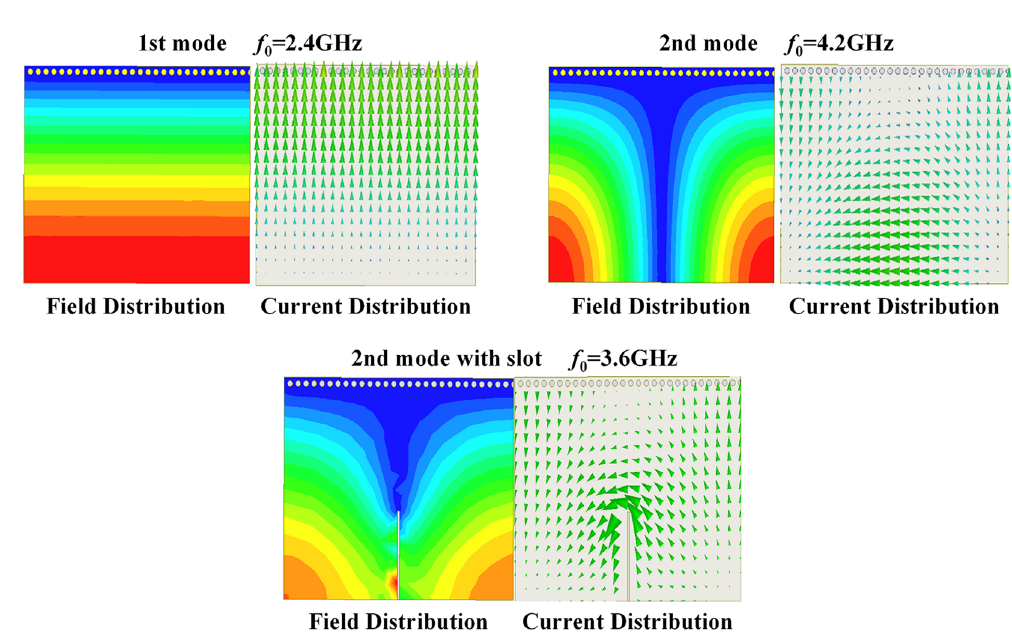
Figure 9. Field and current distribution of HMSIW